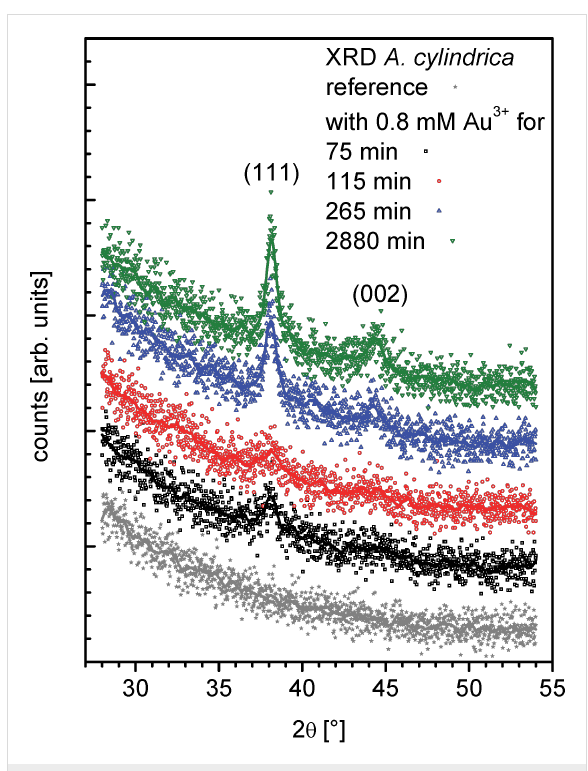
Figure 2: XRD of Anabaena cylindrica samples growing incubated with an overall concentration of 0.8 mM Au 3+ and cultivated without gold salt addition as a reference. Data are stacked for better read- ability: reference (grey filled stars), sample taken 75 minutes (black open squares), 115 min (red open circles), 265 min (blue open trian- gles up) and 2880 min (green open triangles down) after the start of gold salt